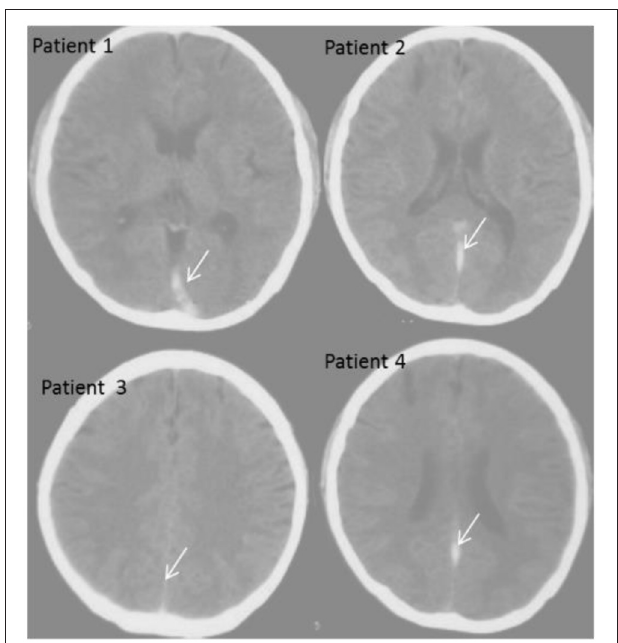
FIGURE 4 | CT diagnosis of the patients with CVT. Patient 1, a male patient aged 36; Patient 2, a female patient aged 40; Patient 3, a male patient aged 34; Patient 4, a female patient age 35.